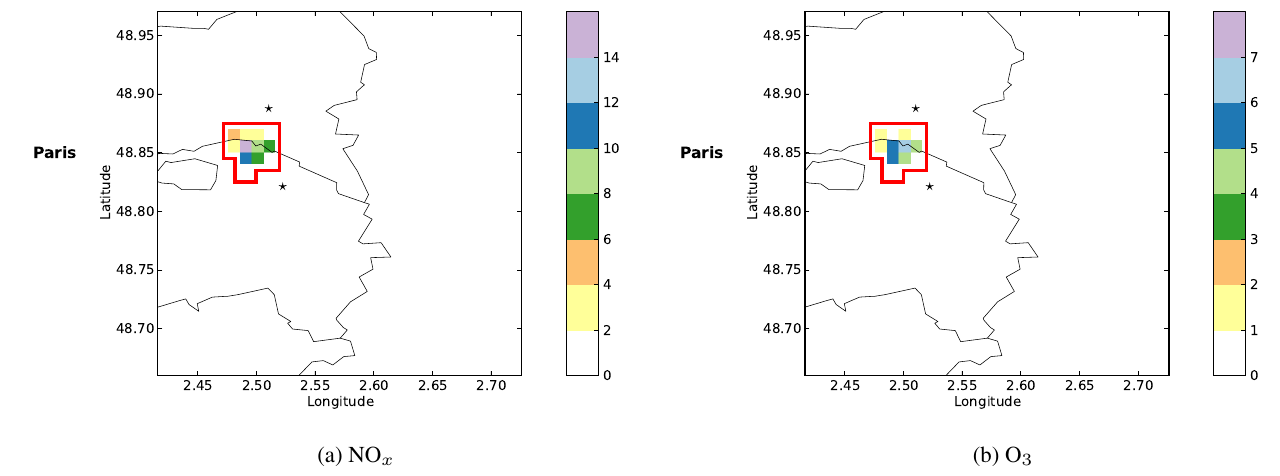
Figure 10. Differences between SinG and Polair3D in the surface concentrations (as a percentage for the means over the whole simulation period) of (a) NO x and (b) O 3 . The red-boundary-enclosed area corresponds to the grid cells where the street network is located. Grid cell concentrations were calculated by combining the street-network and above-rooftop concentrations weighted by the corresponding volumes. The stars show the locations of the urban background air monitoring